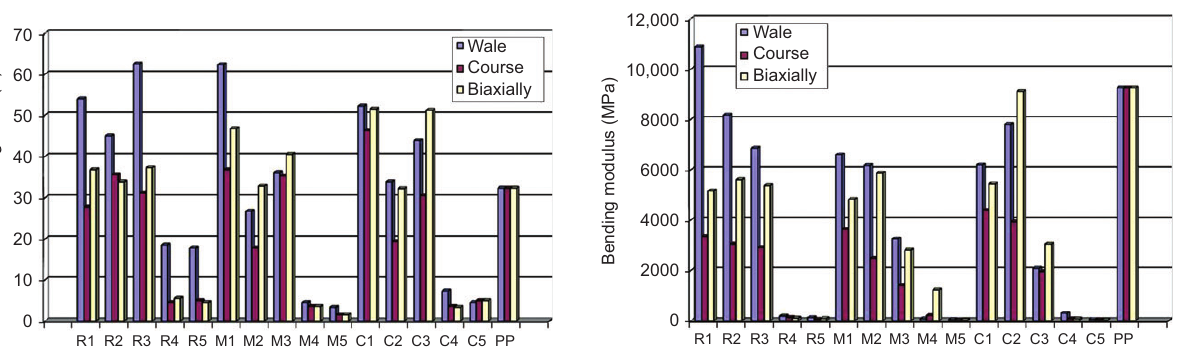
Figure 9 Results of composite ’ s maximum bending force. Figure 10 Results of composite ’ s bending